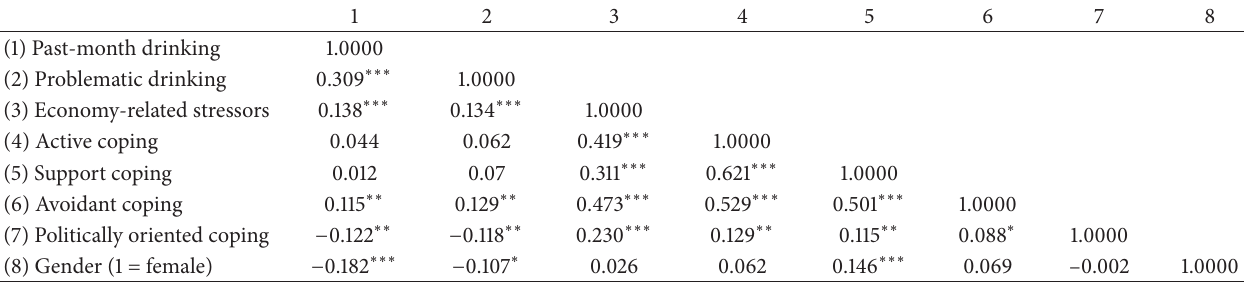
Table 2: Correlation matrix of drinking patterns, economic stressors, and coping strategies ( 𝑁 = 663 ).